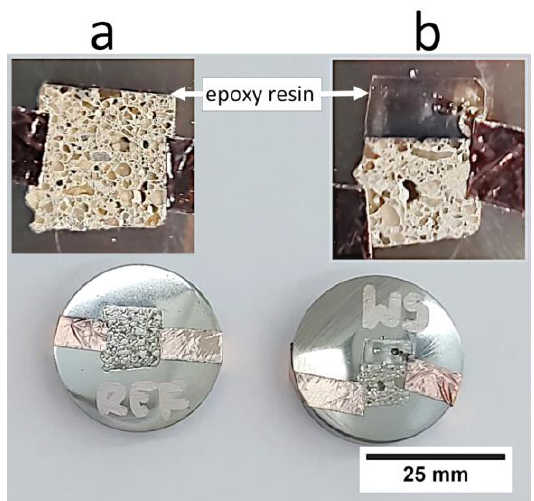
Figure 9. Prepared samples for testing microstructure with a carbon coating: ( a ) reference sample without added fibers, ( b ) sample modified with 0.5 wt % of added fibers.